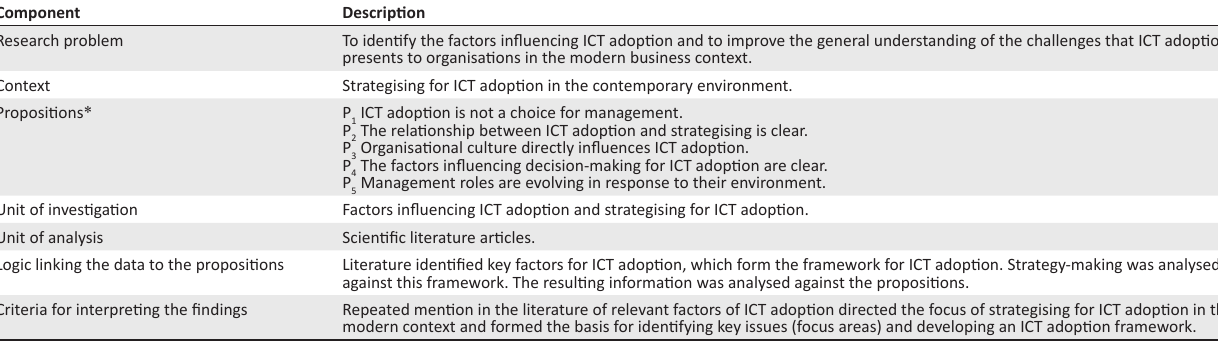
TABLE 1: This article’s research design